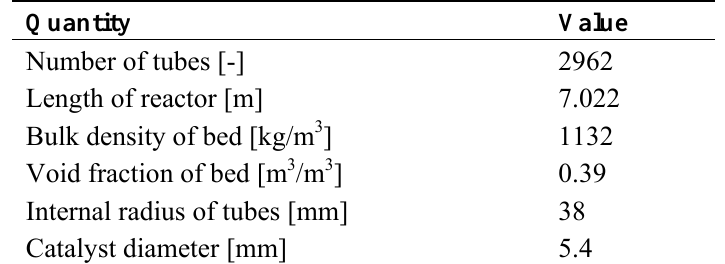
Table 1. Design specifications of Shiraz industrial methanol